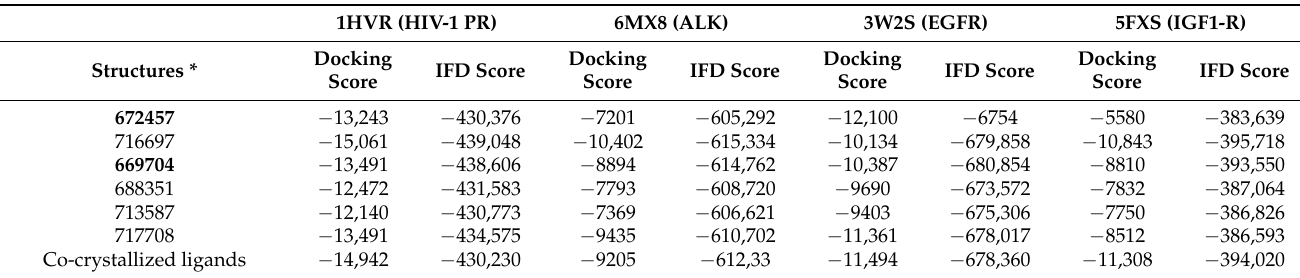
Table 2. Docking and IFD scores of the structures that emerged from the structure-based studies, with the best on/off-target activity balance. 1HVR (HIV-1 PR) 6MX8 (ALK) 3W2S (EGFR) 5FXS